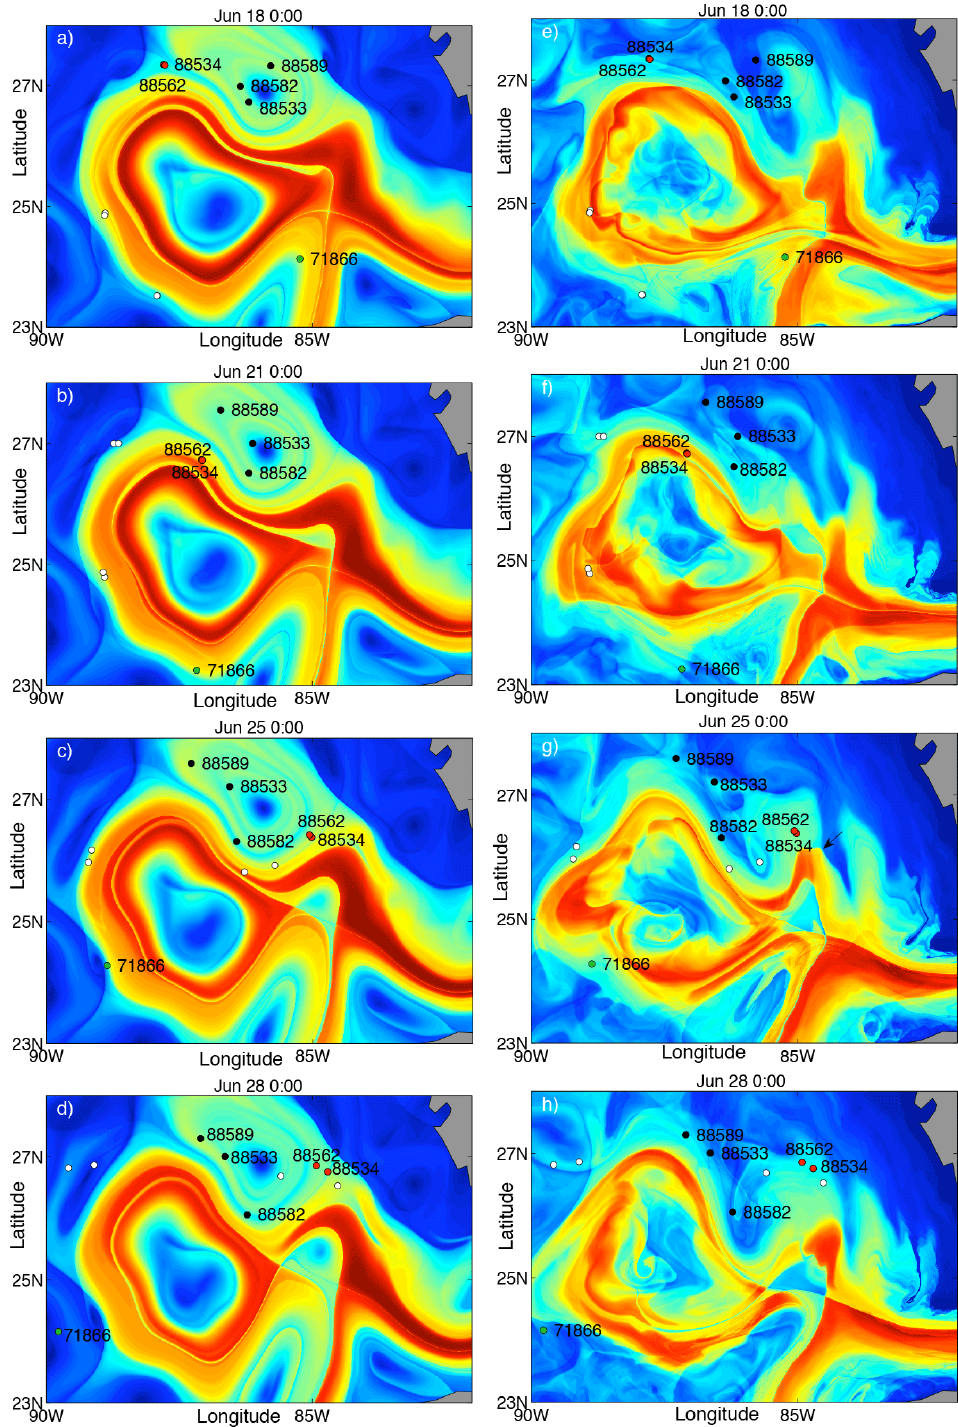
Figure 7. Sequence that shows the evolution of the Lagrangian structures with AVISO – (a) and (d) – and HYCOM – (e) and (h) – data. Drifters “88532”, “88547”, “88590”, “88579”, already depicted in Fig. 6, are represented without labels and in white as before. Drifters “88562” and “88534” are overlapped in red and drifter “71866” in green. Drifters “88589”, “88533” and “88582” are in black. The first row displays results for 18 June, the second for 21 June, the third row for 25 June and the fourth row for 28 June. An arrow highlights the position of a hyperbolic trajectory in (g)